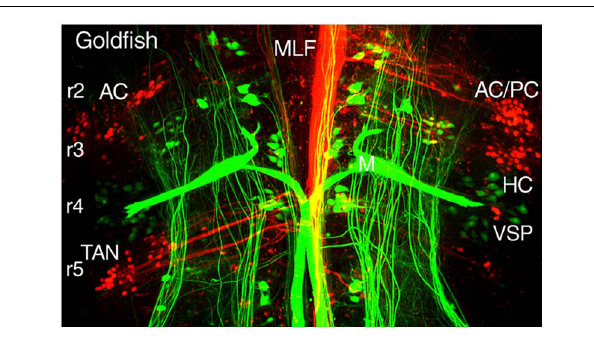
FIGURE 5 | Segmental organizations of vestibuloocular, vestibulospinal, and reticulospinal neurons in a young adult goldfish. A confocal image stack illustrates arrangements of canal-specific oculomotor/trochlear (red) in r2 (AC, PC), r3 (HC), r5 (TAN), and spinal cord-projecting neurons (green) in r4-5 adjacent to the large Mauthner cells in r4. Adapted from Suwa etal. (1996). FIGURE 6